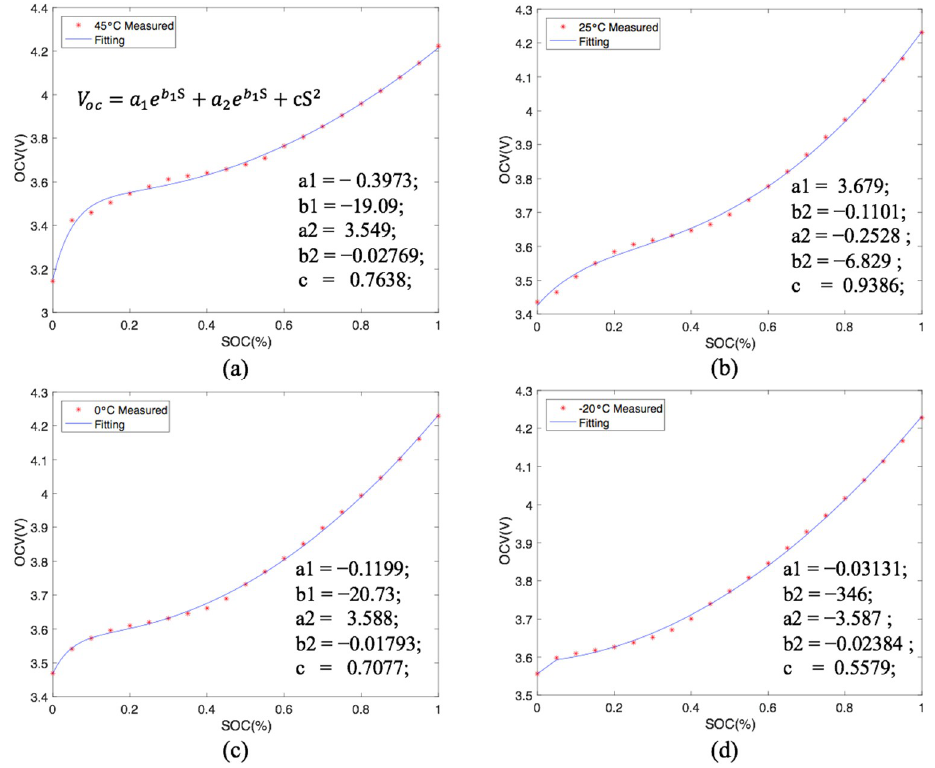
Figure 4. OCV‐SOC measured points and exponential model fitting curves for ( a ) 45 °C; ( b ) 25 °C; ( c ) 0 °C; and ( d ) −20 °C .